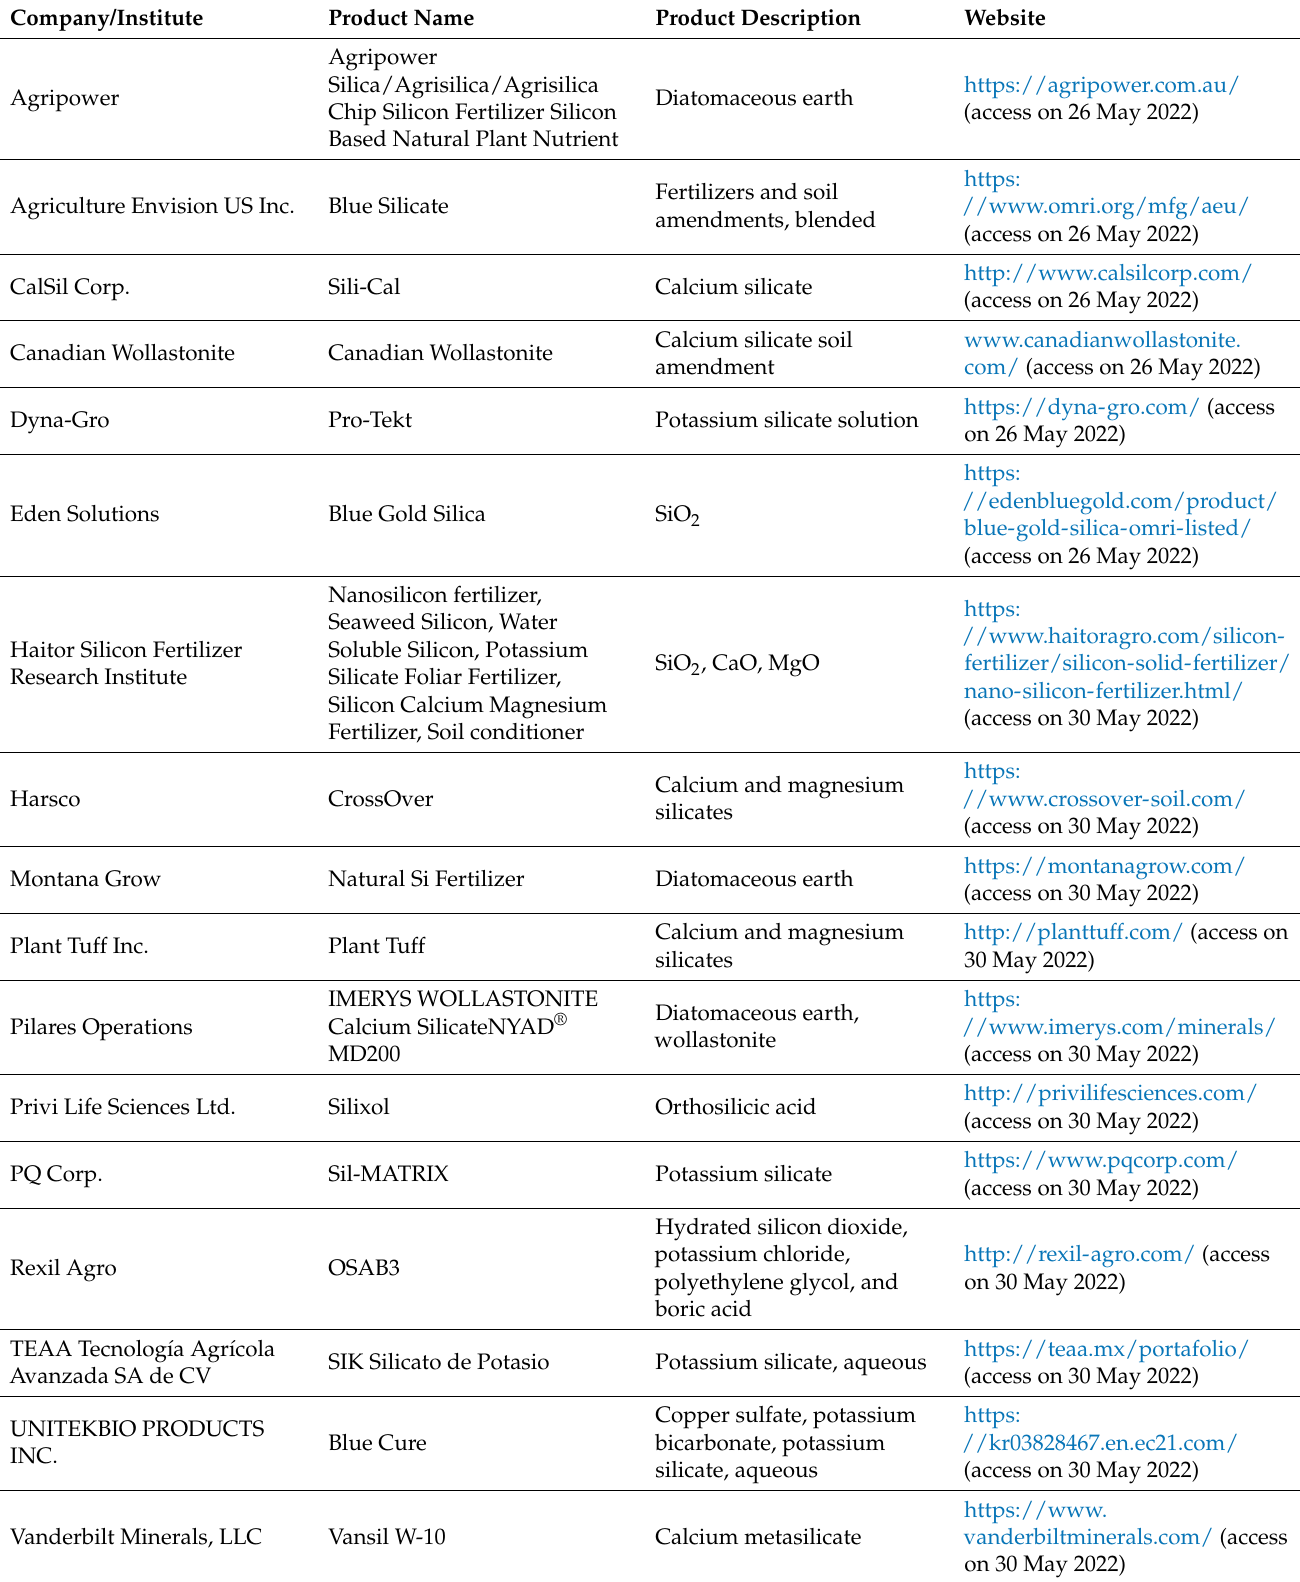
Table 2. List of commercial sources of Si products and relevant